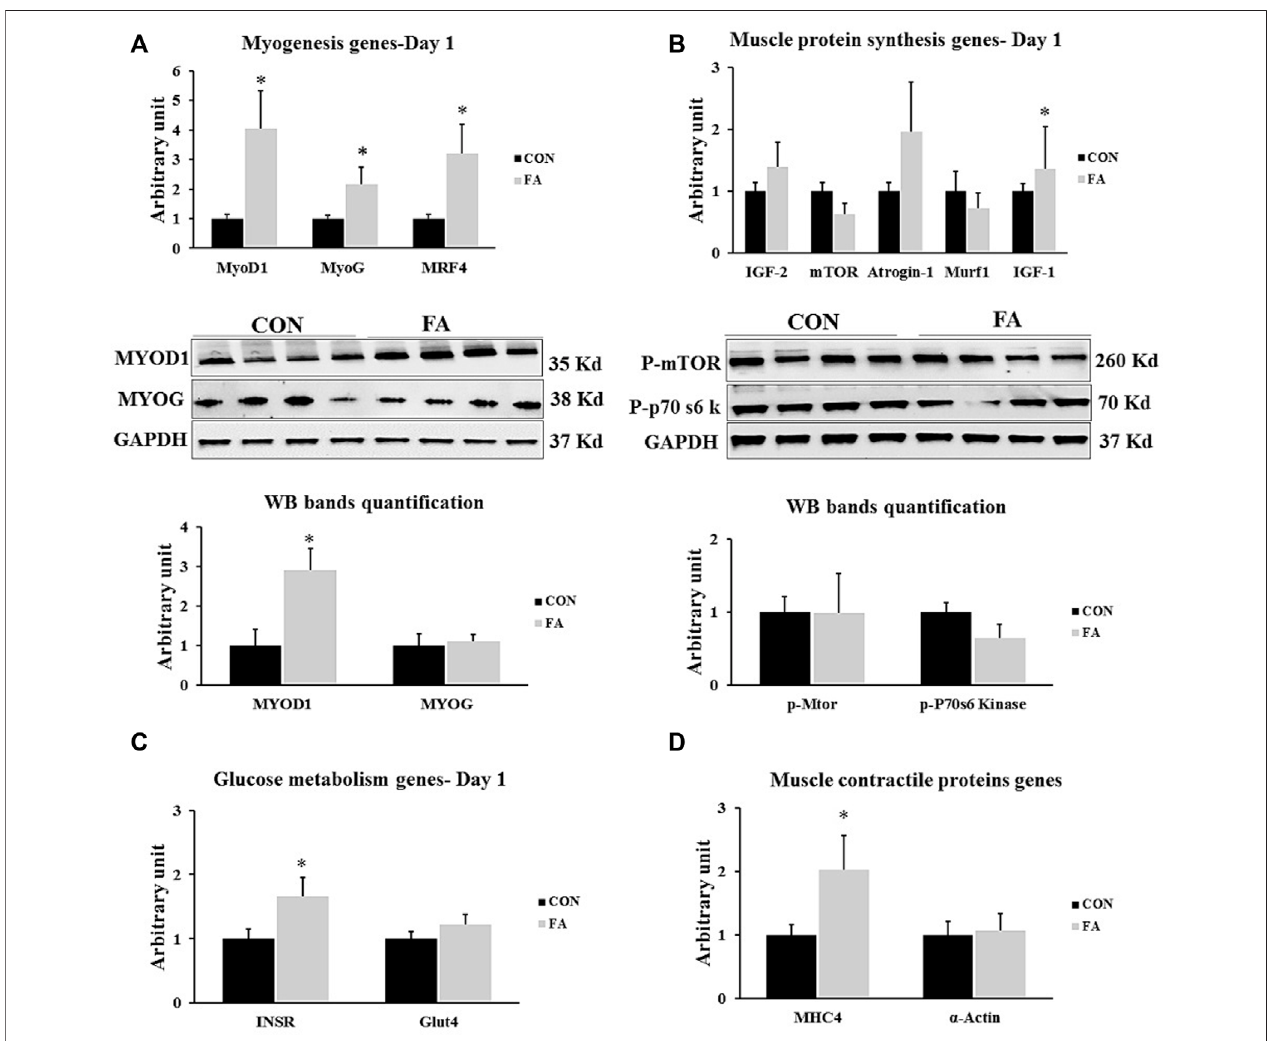
FIGURE 3 | Effect of maternal intake of EPA/DHA on genes regulating myogenesis, muscle protein synthesis, glucose metabolism, muscle contraction, and adipogenesis in day 1 neonates. The mothers were assigned to two groups, one received control diet (CON) and the other was fed EPA/DHA enriched diet (FA) (A) QuantitativeRT-qPCR( n =8)andrepresentativeimageand densitometric analysisofwesternblot( n =4)ofgenesregulatingmyogenesis (B) QuantitativeRT-qPCR( n = 8) and representative image and densitometric analysis of western blot ( n = 4) of genes encoding muscle protein synthesis (C) The relative expression of glucose metabolism regulating genes ( n = 8). (D) qPCR analysis of genes regulating muscle contractile proteins ( n = 8). The raw Ct was normalized to the value of 18 s. All data represent as mean ± SEM. p < 0.05 by Student ’ s t-test.